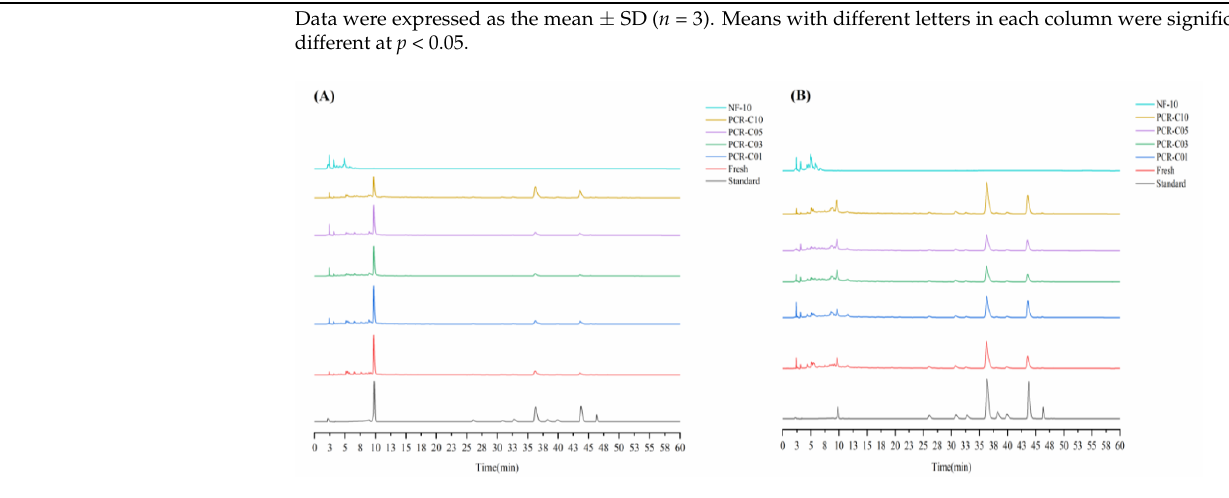
Figure 3. Chromatogram of five PCR-C samples, non-flavonoids-rich PCR-C10 (NF-10), and standard at 280 ( A ) and 330 nm ( B